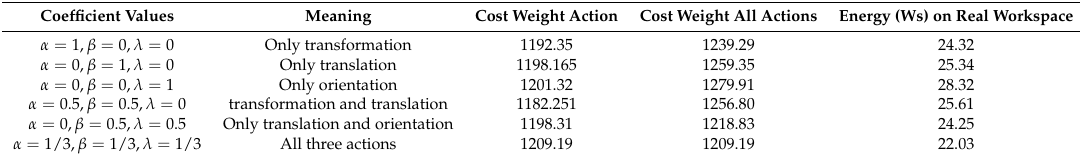
Table 6. Cost weight and trajectory comparison with different coefficients sets for 6 × 6 workspace.